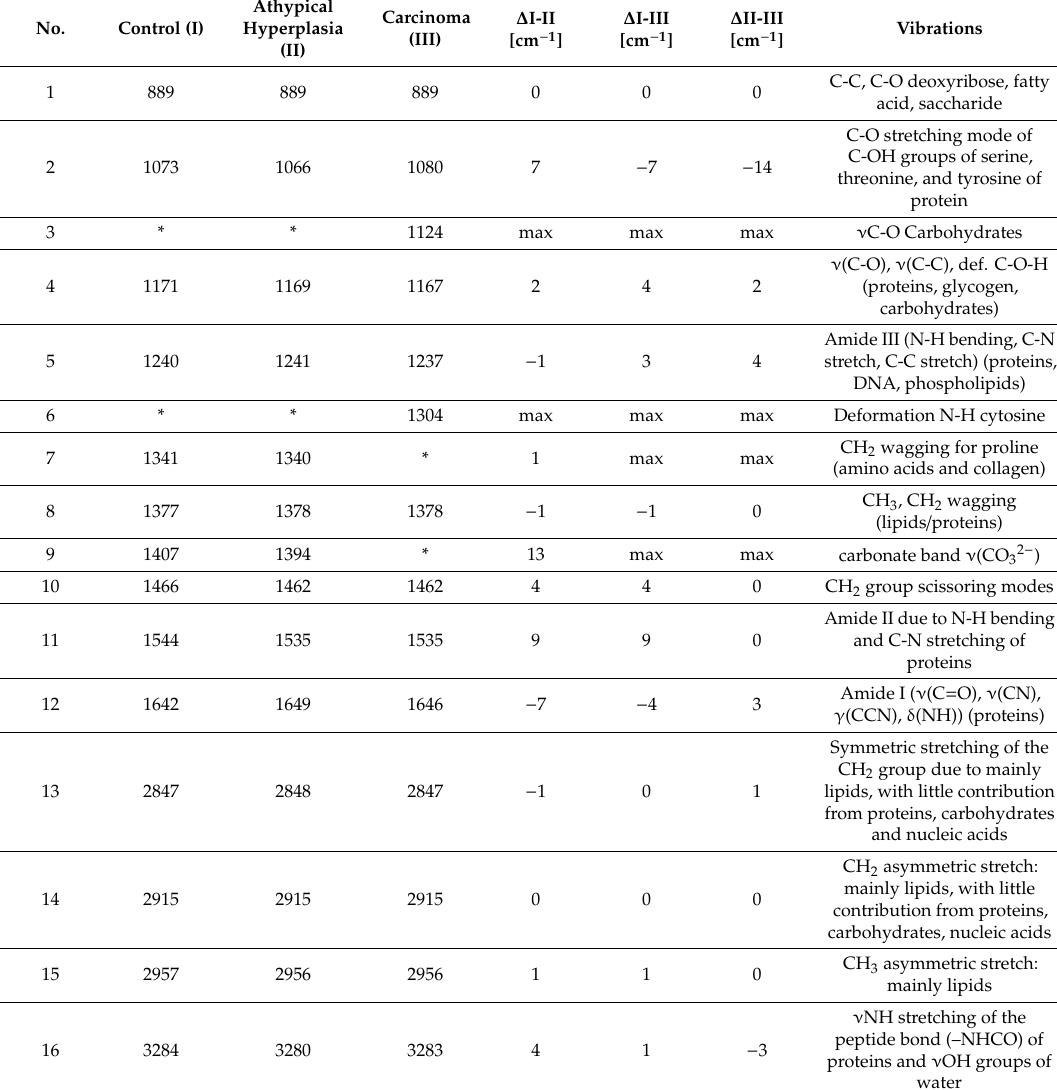
Table 2. Fourier Transform InfraRed (FTIR) shift with corresponding vibrations described in the FTIR spectra of control ( n = 17), atypical hyperplasia ( n = 12) and cancer ( n = 16) tissues [23,24,30–37]. No. Control (I)